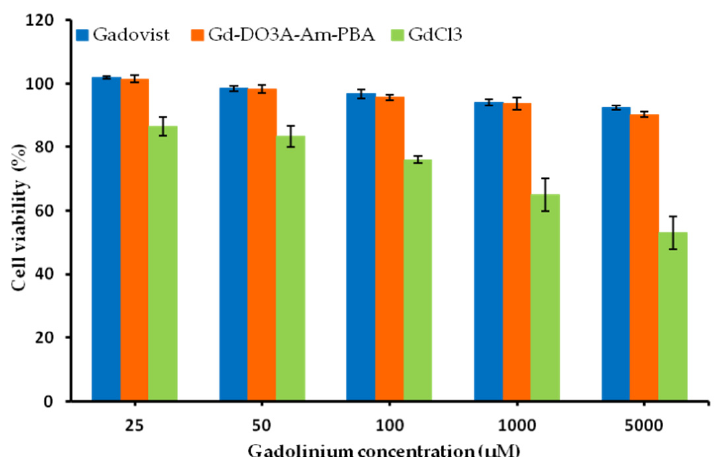
Figure 4. MTT assays. Cell viability (%) of melanoma cells exposed to varying concentrations of Gd-DO3A-Am-PBA, Gadovist, and GdCl 3 for 24 h. Error bars represent mean ± standard error values from three independent experiments.